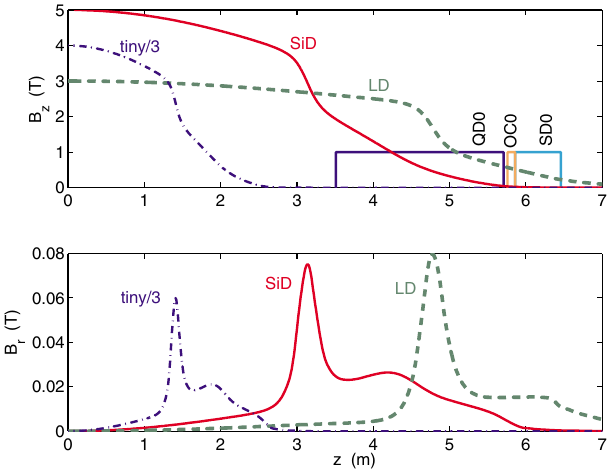
FIG. 4. (Color) Longitudinal and radial fields on the ideal beam trajectory with half crossing angle (cid:13) LD, and tiny detectors. Locations of the final doublet elements are also shown. IP is at z (cid:3) 0 m .